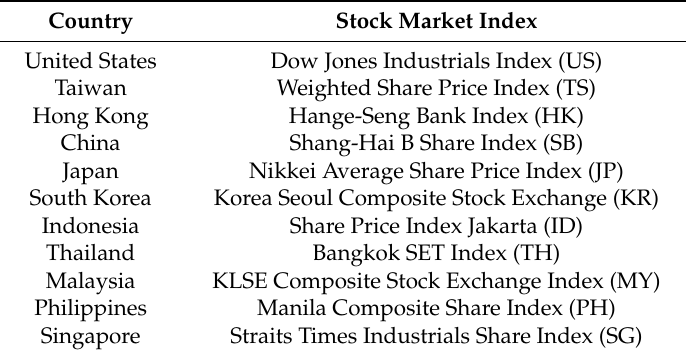
Table 3. Sample country and stock market